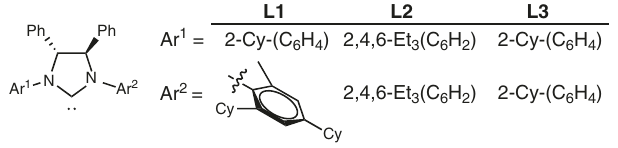
Fig. 2 NHC structures employed in this work. L1 chiral C 1 NHC with unsymmetric N-aryl substituents. L2 chiral C 2 NHC with highly substituted N-aryl groups. L3 chiral C 2 NHC with 2-substituted N-aryl